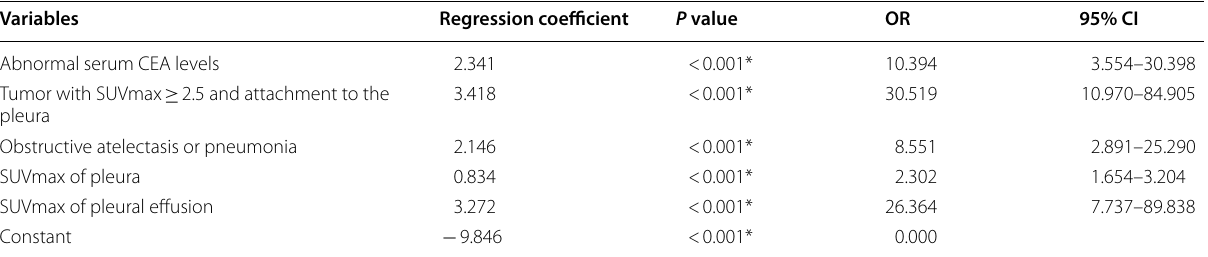
Table 3 Multivariate logistic regression analysis for independent predictive factors of MPE in the training cohort